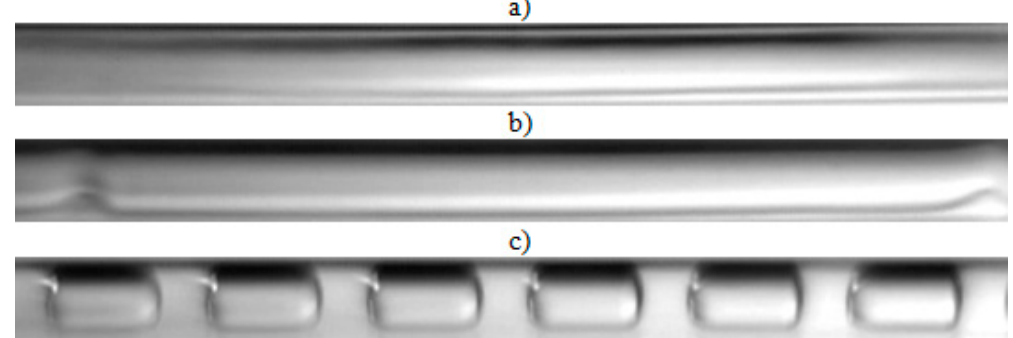
Figure 10. Experimental results of visualization research on Novec649 refrigerant condensation in a minichannel with an internal diameter d h = 0.5 mm: ( a ) annular flow G = 3114 kg/m 2 s, x = 0.056, ϕ = 0.77, t s = 72 °C; ( b ) annular ‐ wavy flow G = 5379 kg/m 2 s, x = 0.023, ϕ = 0.57, t s = 71 °C; ( c ) plug flow G = 5379 kg/m 2 s, x = 0.019, ϕ = 0.53, t s = 71 °C.